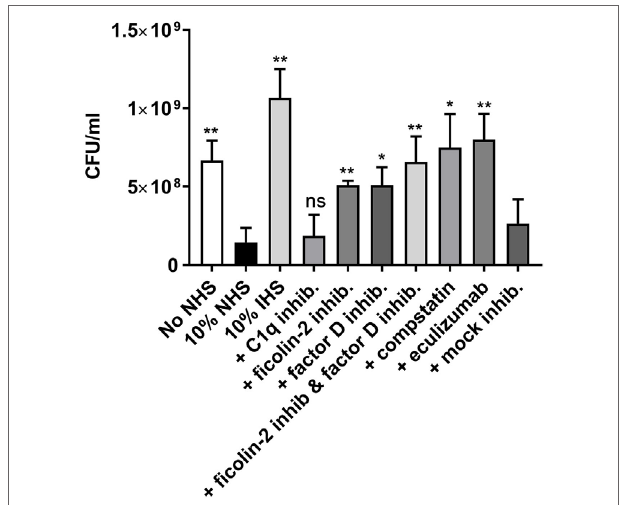
FigUre 9 | Inhibitors of ficolin-2 and factor D reduce serum-mediated enteroaggregative Escherichia coli (EAEC) killing. Bacterial growth in normal human serum (NHS) measured by colony-forming unit (CFU)/ml. EAEC isolate C322-17 was incubated with 10% NHS in combination with complement inhibitors of ficolin-2, factor D, C1q, C3 (compstatin), and C5 (eculizumab). A baseline (No NHS) was established from an overnight culture under normal growth conditions without the presence of NHS or inhibitors. Results represent the means of three independent experiments ± SD. All conditions are compared to 10% NHS, ns p > 0.05, * p ≤ 0.05, ** p ≤ 0.01 (unpaired Student’s t